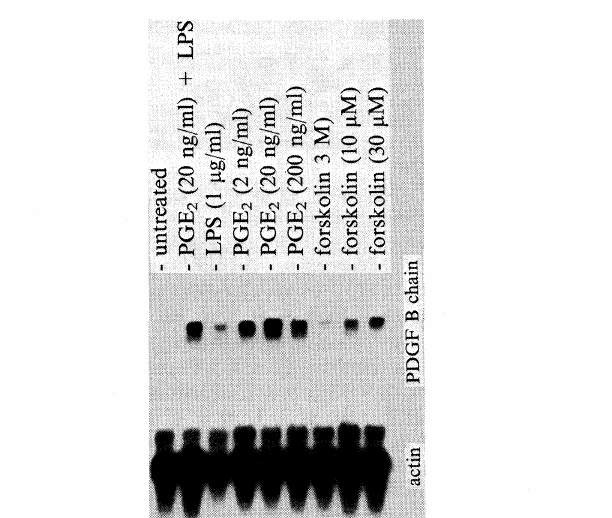
FIG. 1. Effects of PGE2 and agents which elevate intracellular cAMP on the expression of PDGF B chain mRNA. ANA-1 cells were cultured with or without inducing for 6h. Blots were hybridized sequentially with probes for PDGF B chain and